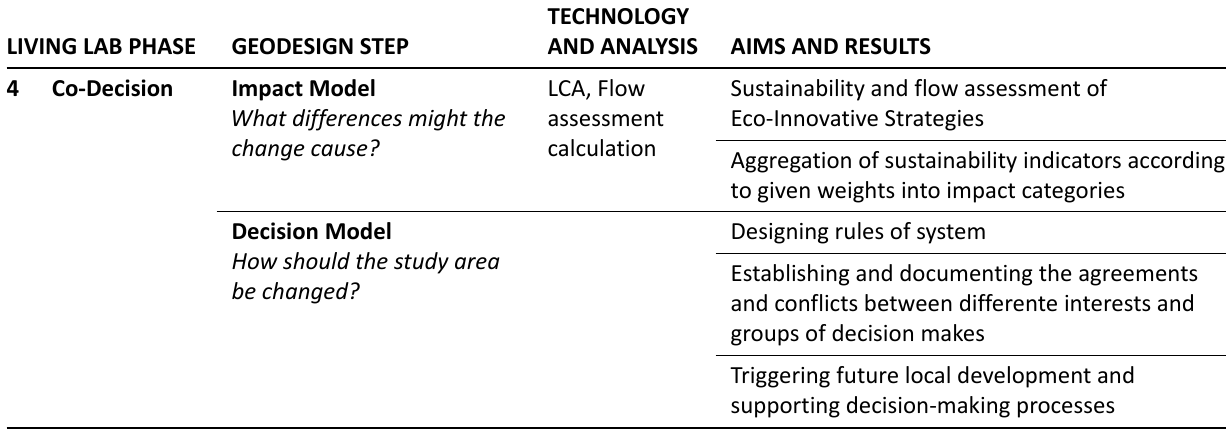
Table 5. Addressing geodesign questions at the PULL phase